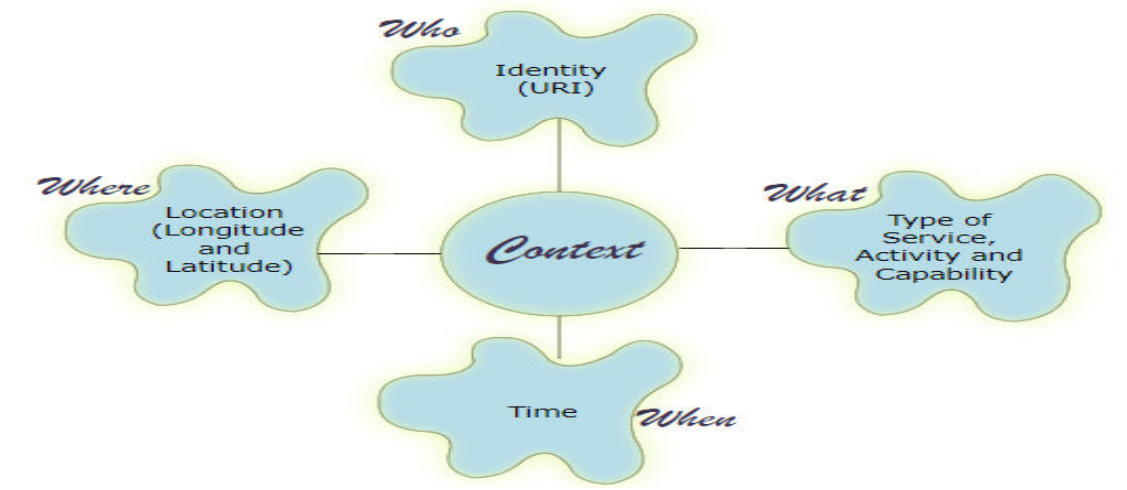
Figure 2. Categories of the context in CATSWoTS.